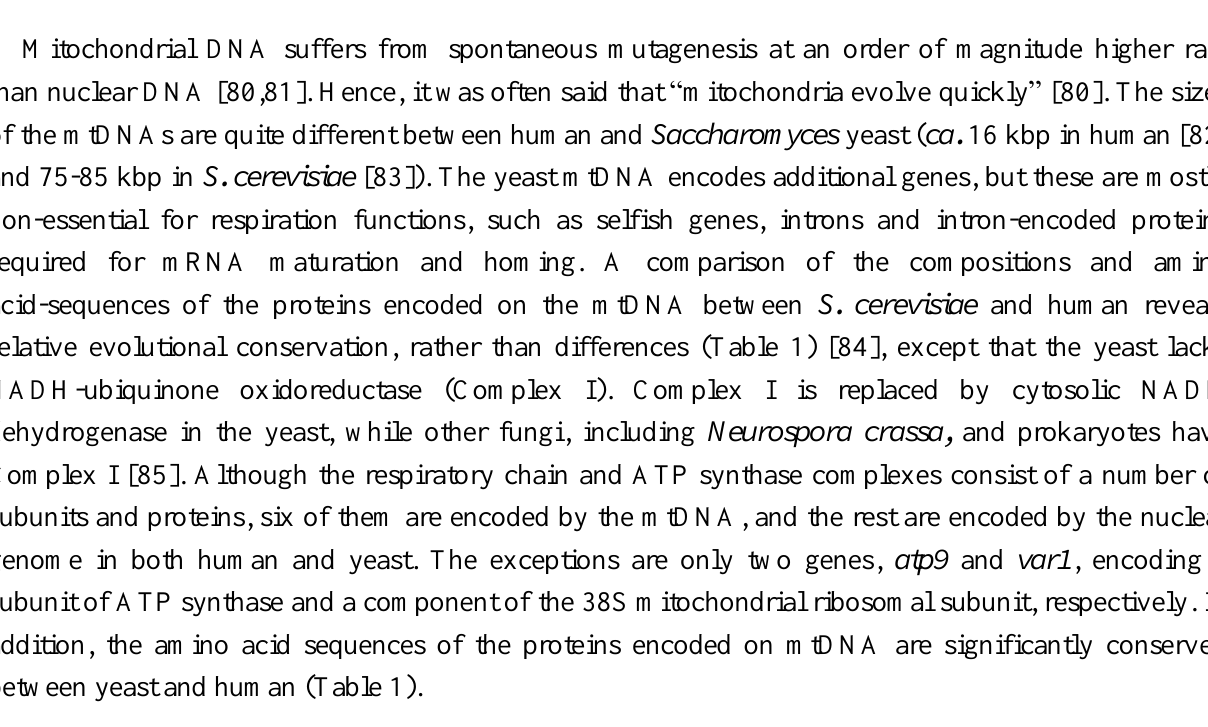
Table 1. Proteins encoded by the human and the yeast mitochondrial